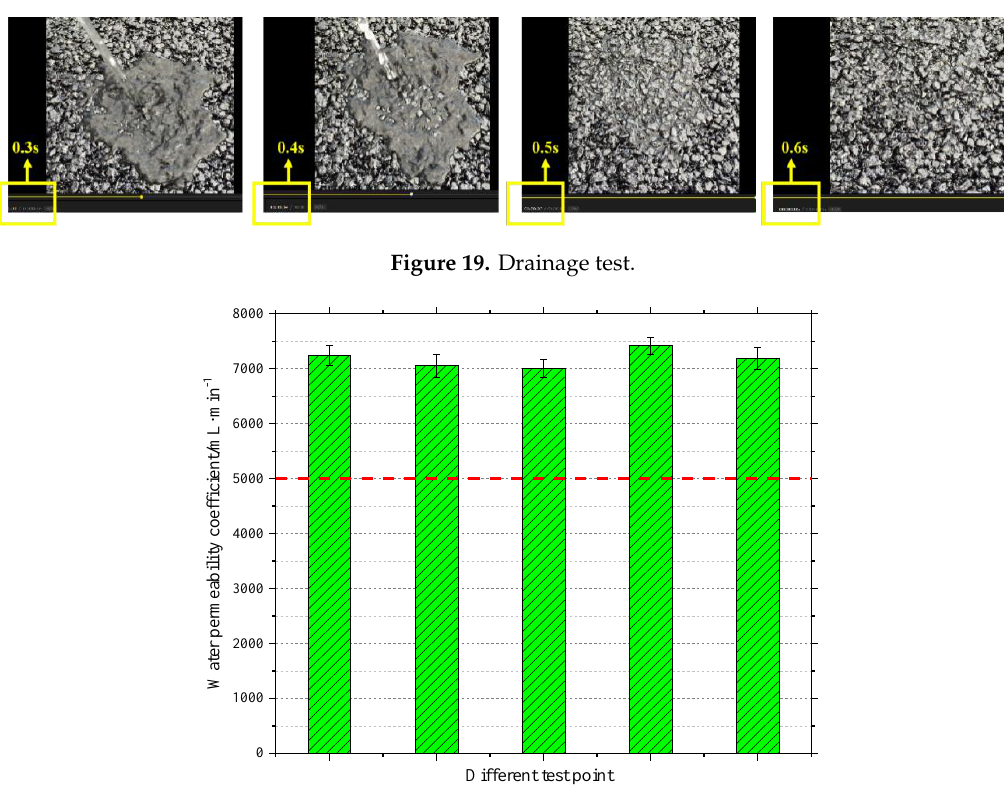
Figure 20. Water permeability coe ffi cients at di ff erent test points. Figure 20. Water permeability coefficients at different test points. Figure 20. Water permeability coefficients at different test points. Figure 20. Water permeability coefficients at different test points.